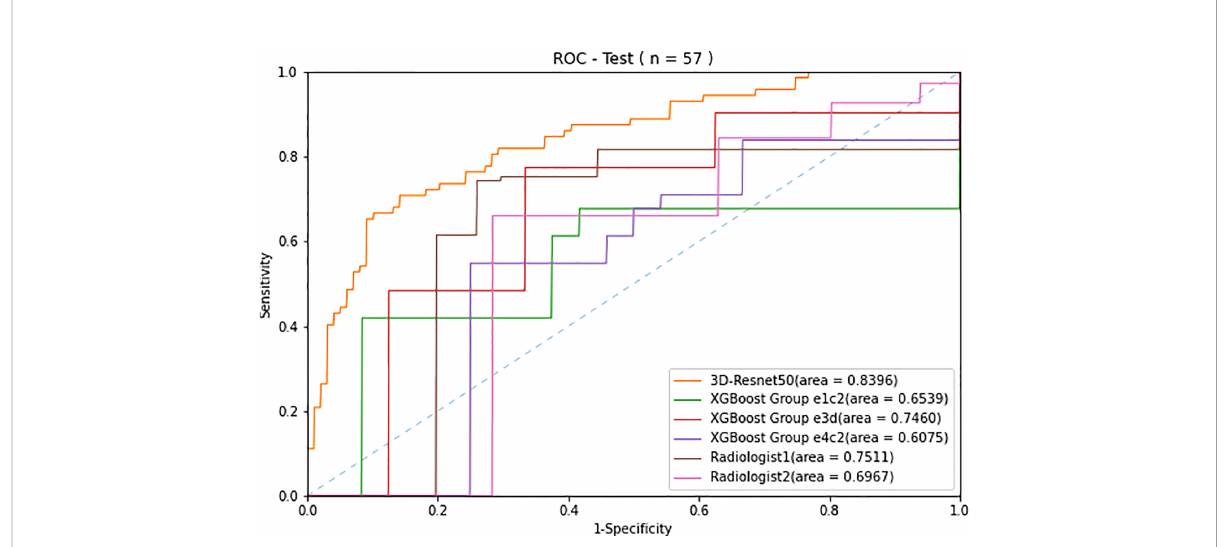
FIGURE 3 Receiver operating characteristic (ROC) curves of the two radiologists compared with the 3D-Resnet-50 model and radiomics combined with the XGBoost model with three different data sampling methods in the test